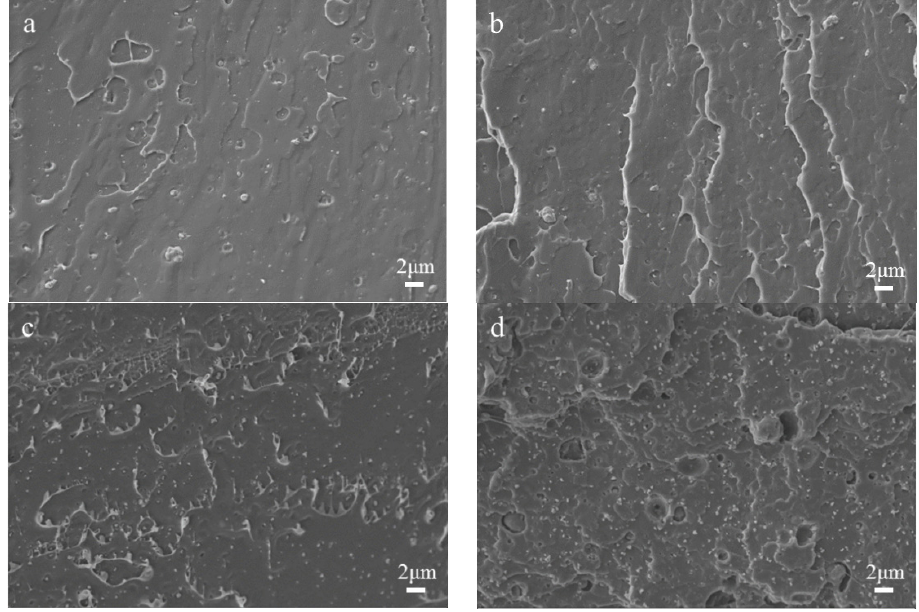
Figure 5. SEM image of TiO 2 on the PLA cross section before and after modification: ( a ) 1% TiO 2 /PLA; ( b ) 3% TiO 2 /PLA; ( c ) 5% TiO 2 (KH-570)/PLA; ( d ) 10% TiO 2 (KH-570)/PLA.